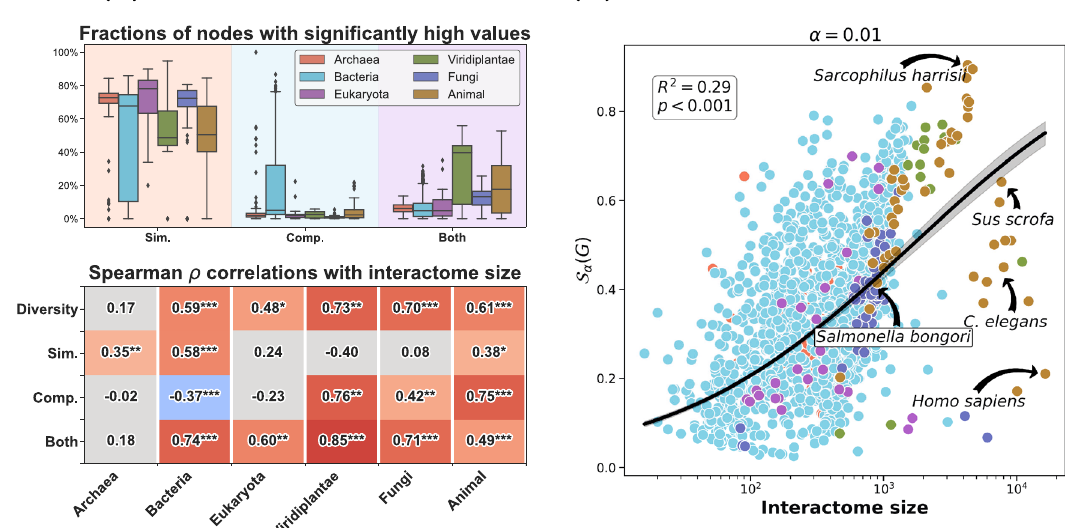
Figure 8. Structural diversity of 1840 interactomes across the tree of life 45 (see “Materials and methods” section). The analysis was based on proportions of nodes with significantly high values ( p ≤ α = 0.01 ) of structural coefficients s i and c i or both of them. We also conducted a sensitivity analysis for alternative levels α = 0.05, 0.10 (SI: Structural diversity analysis). Significance was based on null distributions estimated with 100 samples from UBCM. ( A ) We followed the division into the domains of Archaea, Bacteria and Eukaryota 46 , but also distinguished three arguably most complex taxa within eukaryotes: green plants (Viridiplantae), fungi and animals (Metazoa). The two “other” classes consist of all other eukaryotes. ( B ) Evolution time and interactome sizes in groups. ( C ) Proportions of nodes with significant values of s i are high in all groups, but tend to be lower among bacteria, which are the only group that feature relatively large numbers of proteins with high structural complementarity. Crucially, it is the more complex eukaryotes, particularly animals and plants, which feature many nodes with significantly high values of both s i and c i . This suggests that interactomes of more complex organisms tend to be more structurally diverse. The lower panel shows Spearman ρ correlations between interactome size and the proportions as well as the diversity index (16); ∗∗∗ p ≤ 0.001 , ∗∗ p ≤ 0.01 , ∗ p ≤ 0.05 ; Holm–Bonferroni correction for multiple testing was used. Notably, in all groups except Archaea the correlations between interactome size and the diversity index as well as the “both” proportion are strongly positive. Moreover, complementarity increases with network size in plants, fungi and animals but decreases in bacteria, which means that in both cases the general trend goes in the direction of greater structural diversity. ( D ) Structural diversity and interactome size. The general correlation is positive and relatively